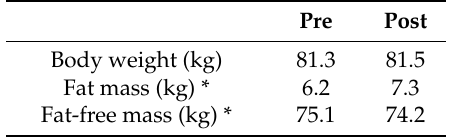
Table 1. Calculated values of fat and fat-free mass from the reported mean